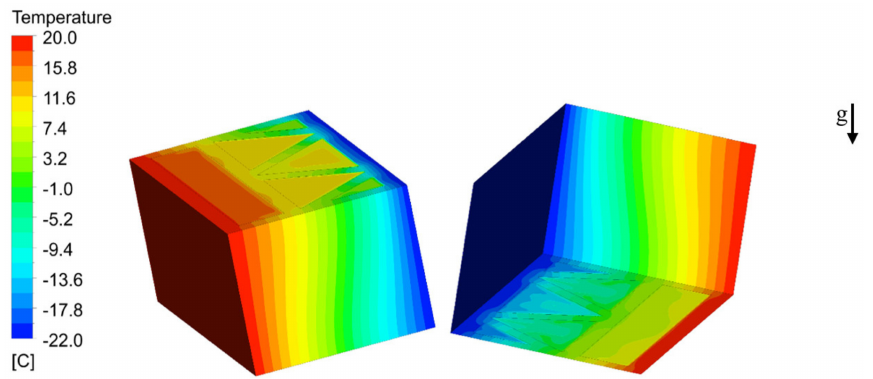
Figure 9. Temperature field on the construction.